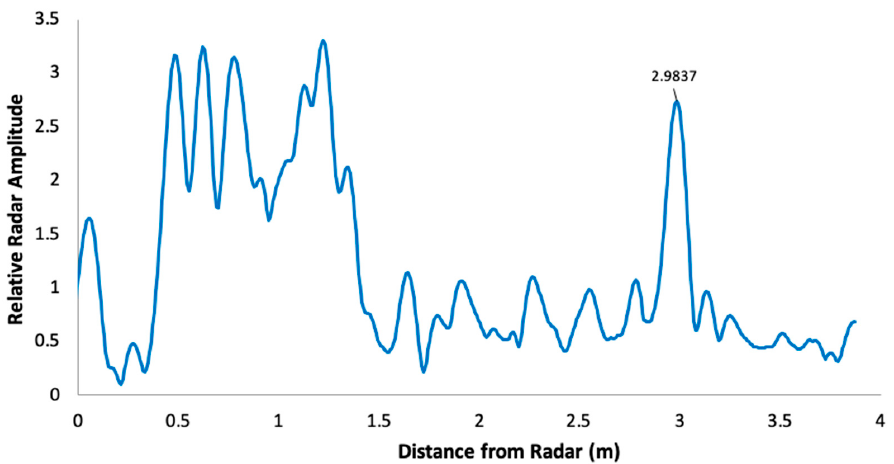
Figure 12. Measured relative radar amplitude signal over dry snowpack (snow depth of 237 cm). The right-most peak, at a distance of 298 cm (snow/plate interface) from the radar, allowed us to estimate the mean snow permittivity when the measured snow depth was known (Equation (8)). Intermediate peaks correspond to layering within the snowpack (see Discussion).